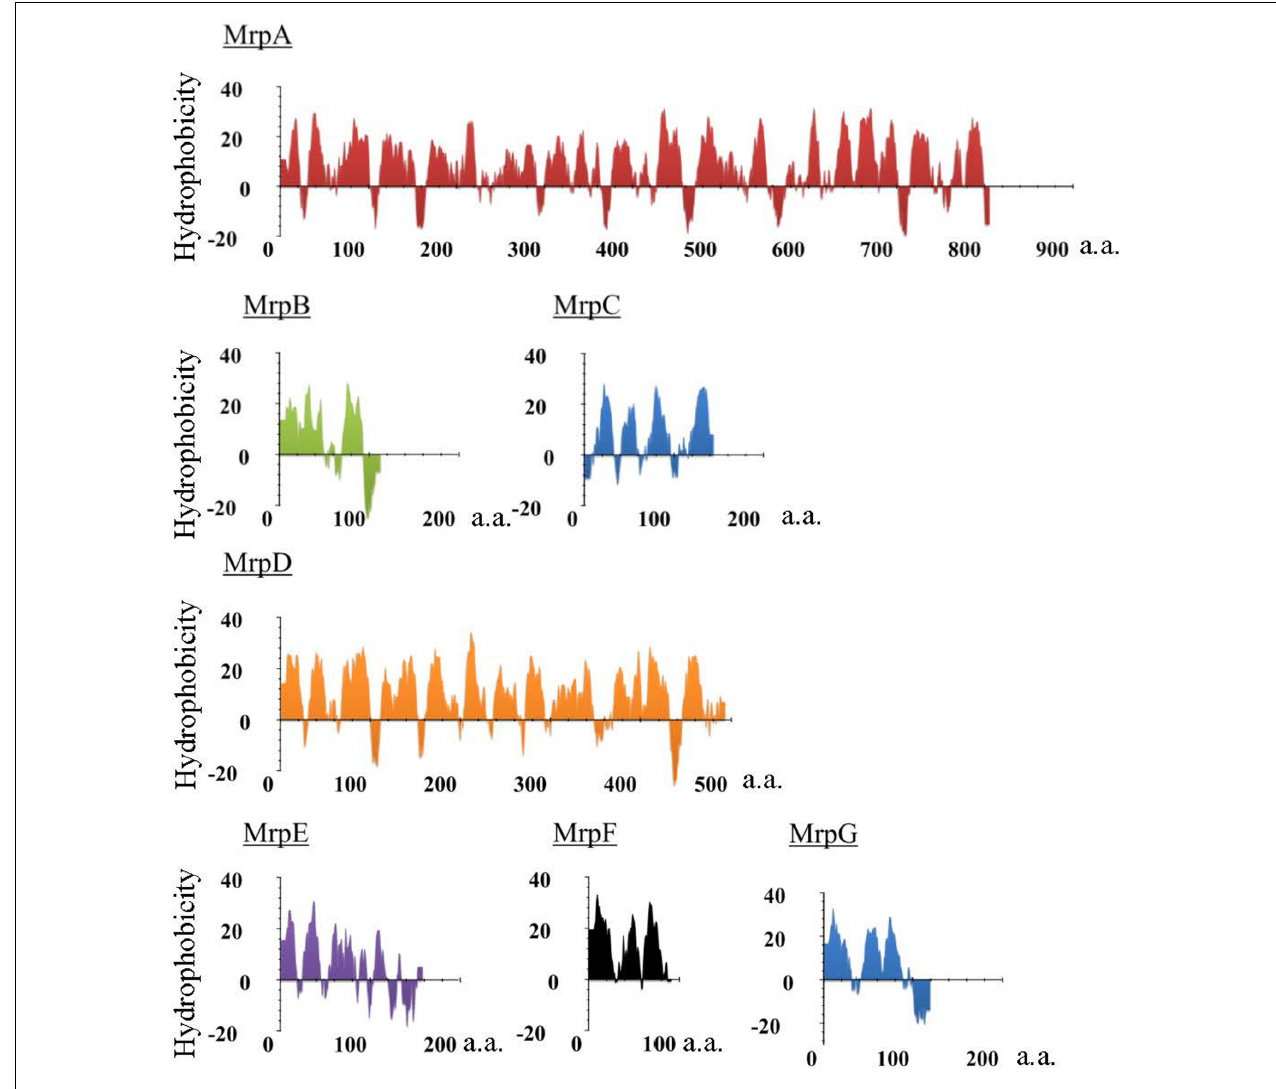
FIGURE 1 | Hydropathy profile of the Mrp subunits derived from alkaliphilic B. pseudofirmus OF4. The hydropathy profile of the Mrp subunits derived from B. pseudofirmus OF4 was predicted using Kyte and Doolittle method. The vertical axis represents the degree of hydrophobicity, and the horizontal axis represents the number of amino acids